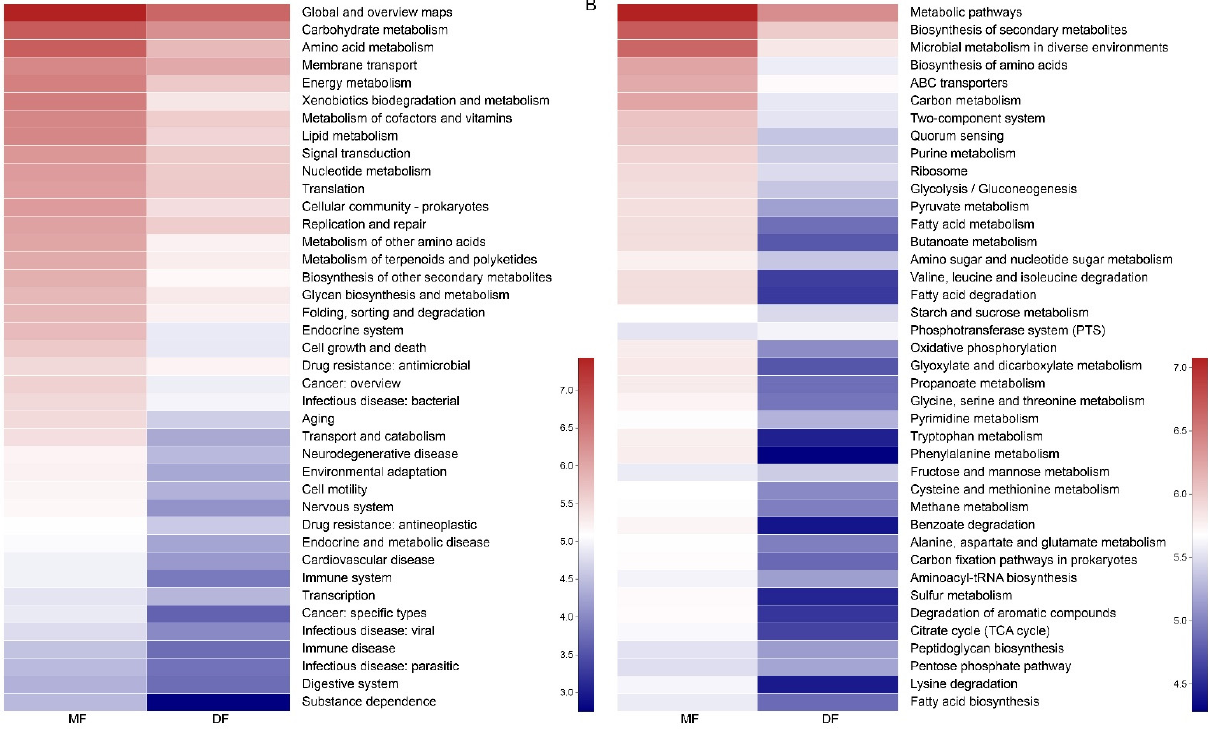
Figure 6. Functional gut microbiota profiles of S. frugiperda fed different diets at ( A ) KEGG-level 2 and ( B ) KEGG-level 3.